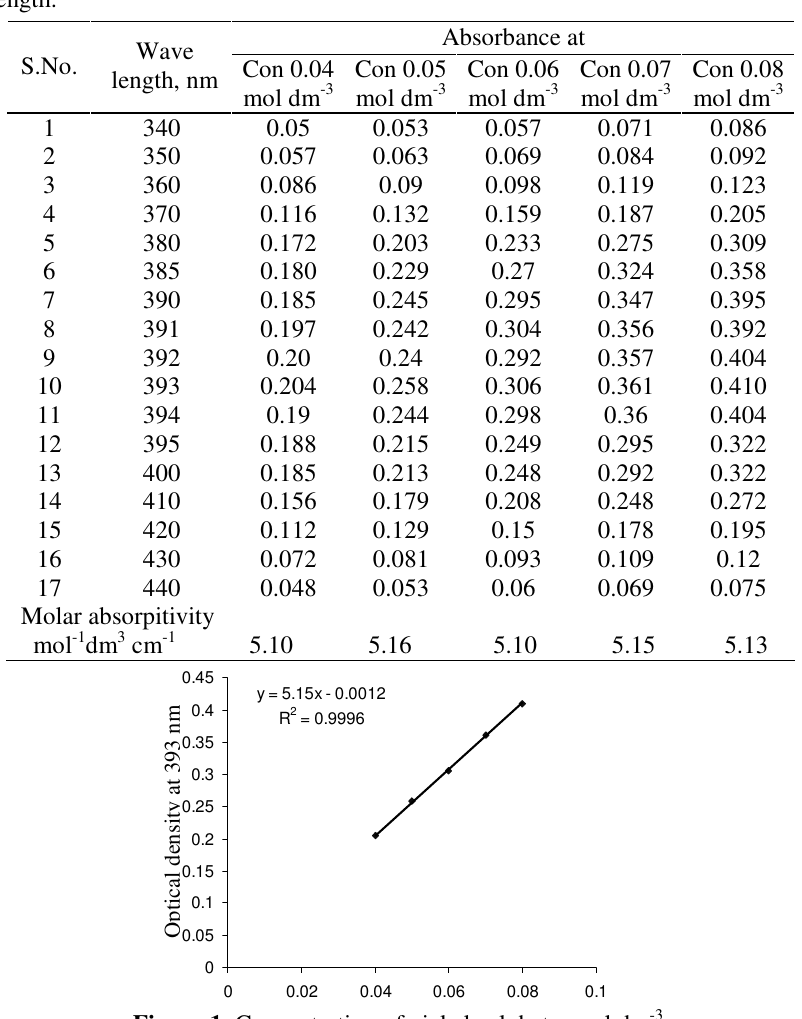
Figure 1. Concentration of nickel sulphate, mol dm -3